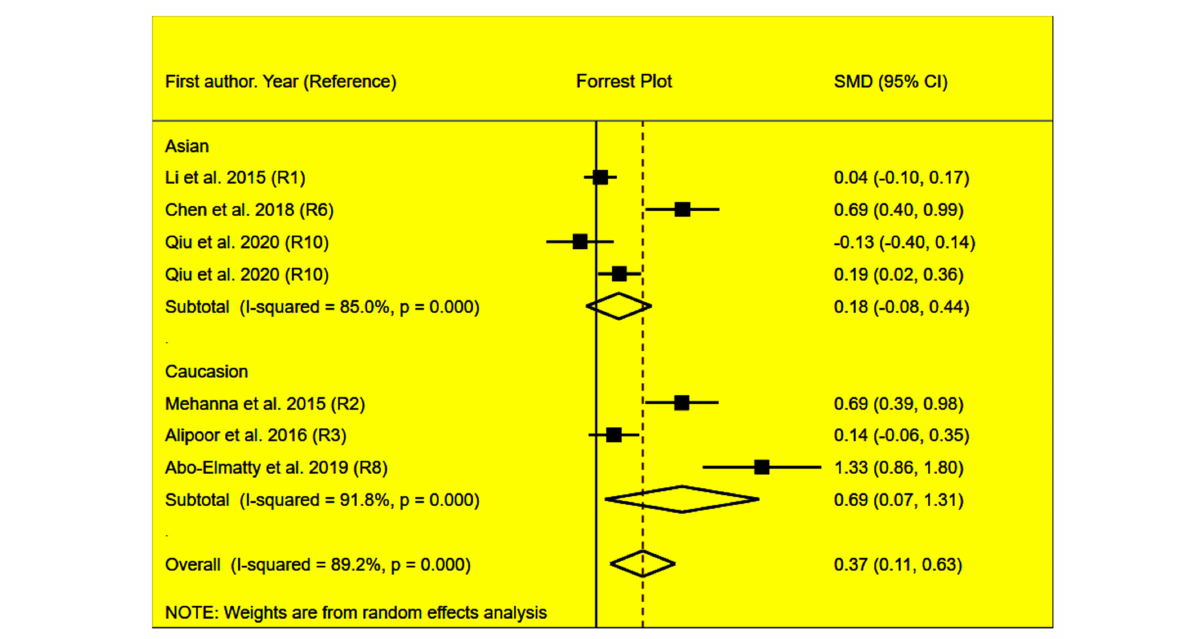
Frontiers in Genetics |